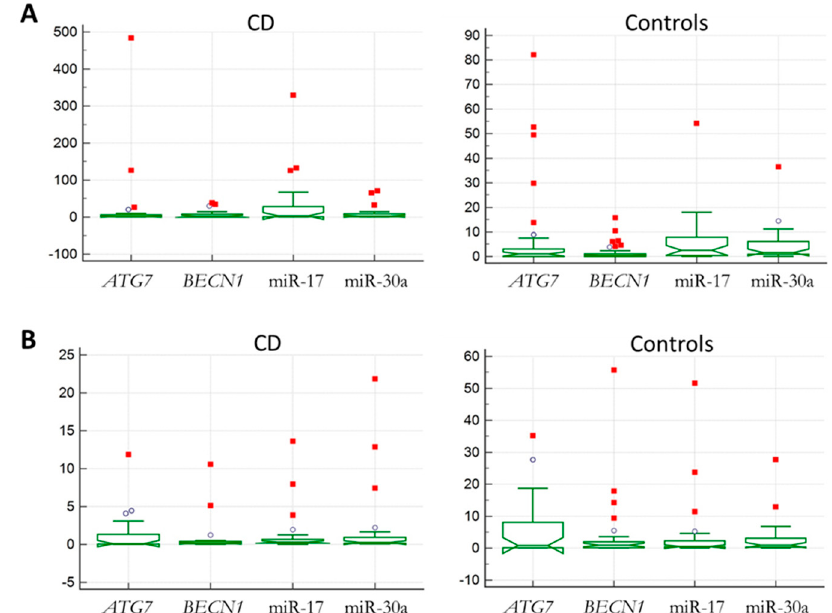
Figure 1. Expression profiles of autophagy-related genes and miRNAs in the investigated tissues. Notched box-and-whisker plot of the expression values obtained by real-time PCR from blood ( A ) or intestinal biopsies ( B ) of celiac disease (CD) patients and controls. In the Y axes, the relative quantitative expression (RQ) values are reported. Outliers ( circles ) and far-out values ( squares ) are indicated. Differently, in intestinal biopsies, ATG7 showed the highest expression profile variability in both groups (Figure 1 B ).